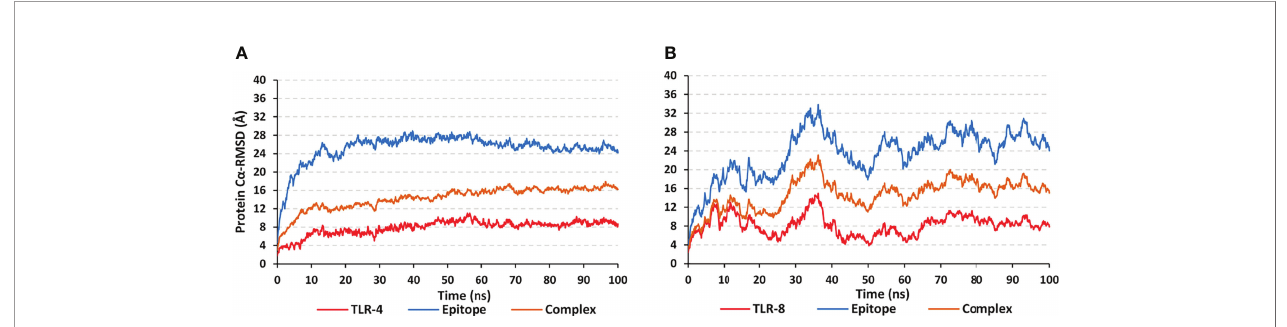
FIGURE 6 | Trajectory-based thermodynamic stability analysis of the simulated multiepitope vaccine in complex with different TLRs along 100 ns all-atom simulation runs. The estimated C a RMSDs (Å) of simulated (A) epitope/TLR-4 model; (B) epitope/TLR-8 model, were represented as a function of molecular dynamics timelines